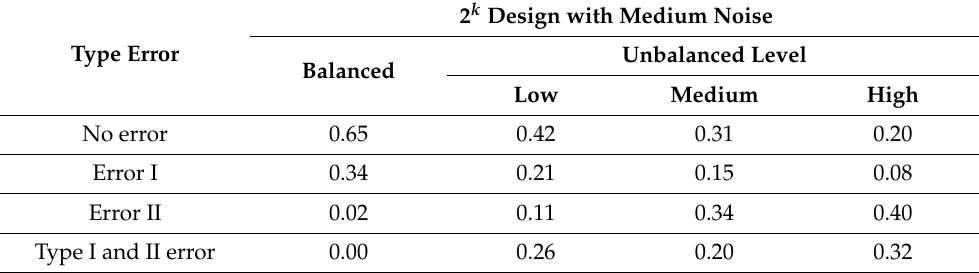
Table 12. Values for different levels of unbalance with medium noise.